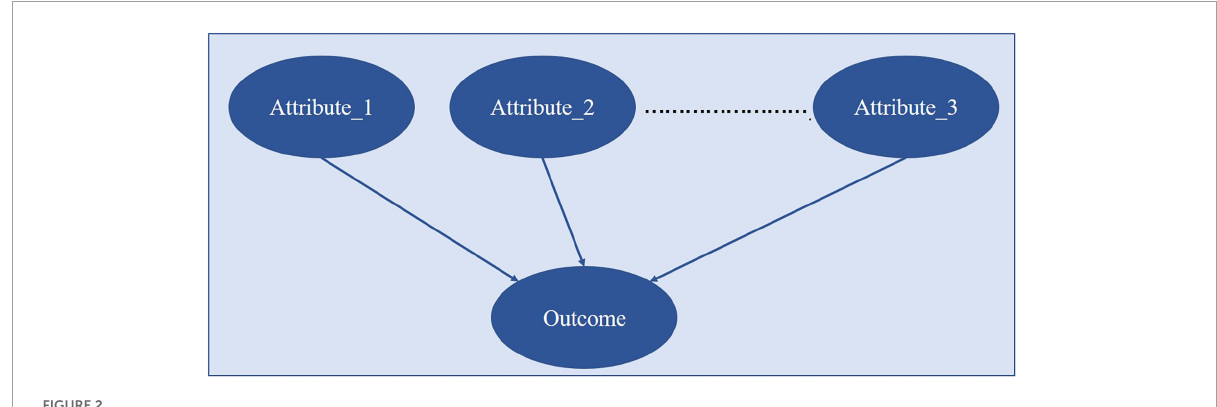
FIGURE2 The analysis of indicator combination of BN